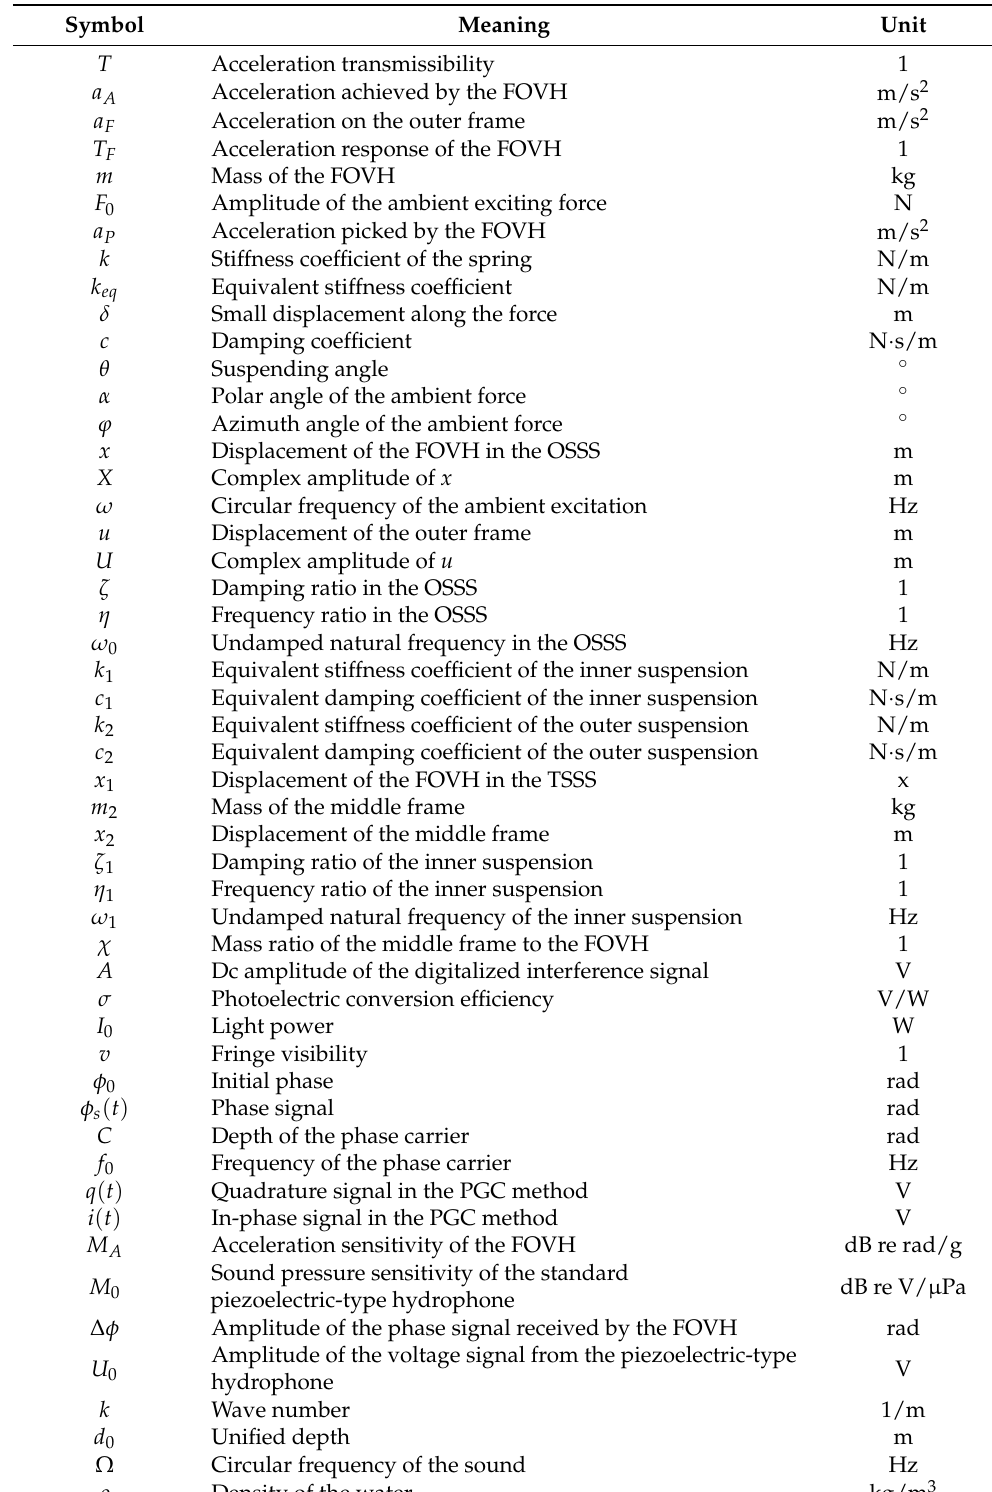
Table A1. The symbols used in the